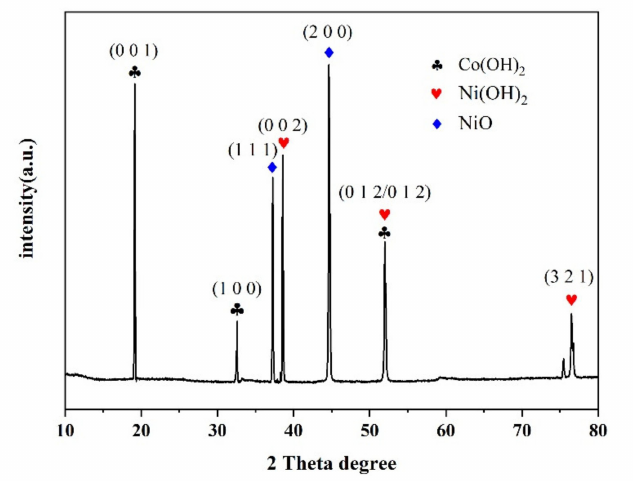
Figure 2. XRD patterns of NiCo(OH) 4